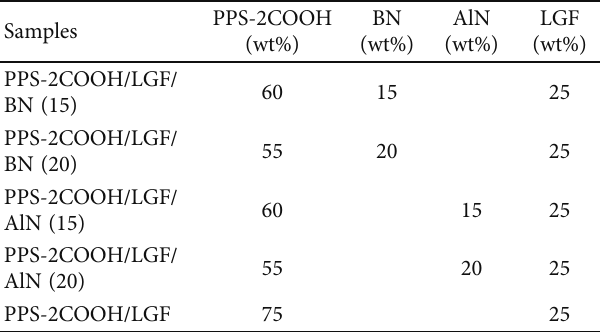
Table 1: Composition of the PPS-2COOH/LGF/AlN and PPS- 2COOH/LGF/BN composites in